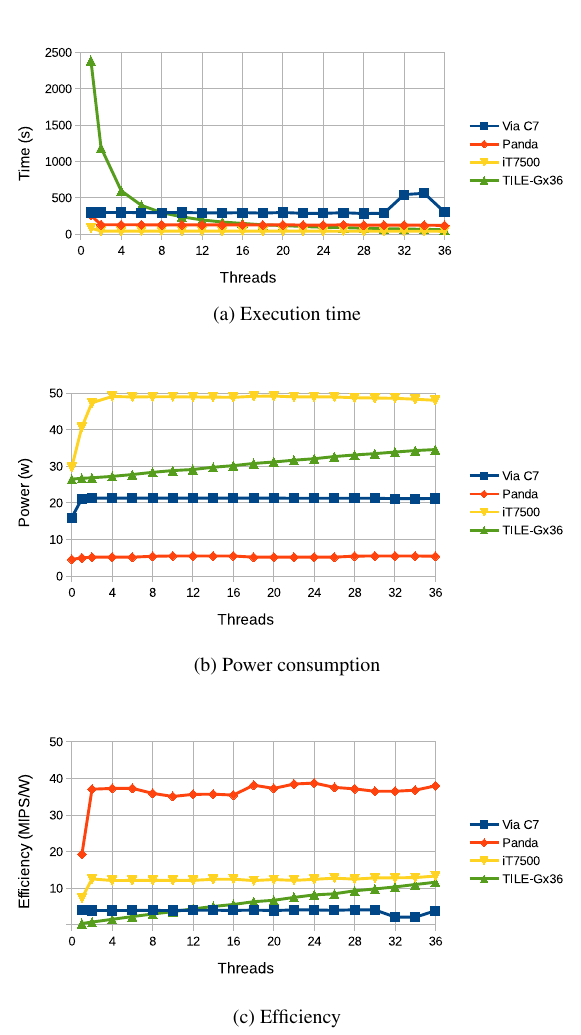
Figure 3: Benchmarking